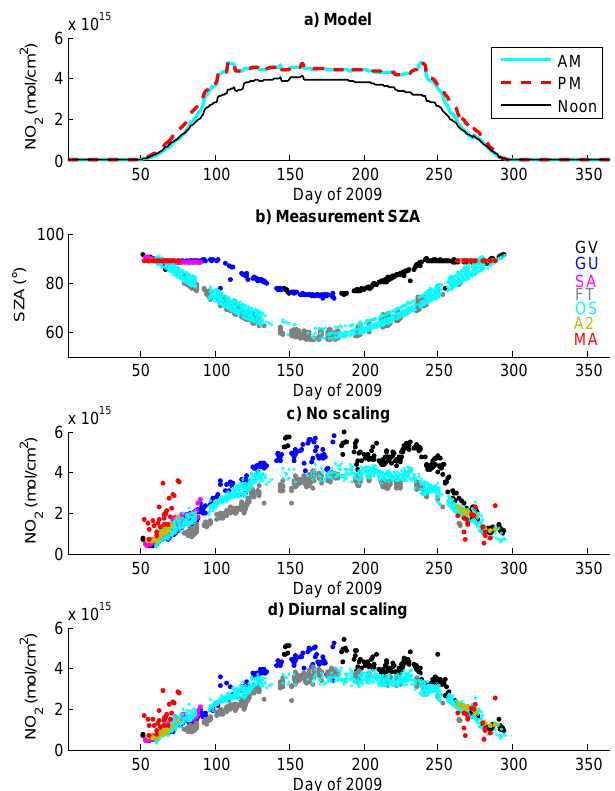
Fig. 3. Seasonal evolution of NO 2 in 2009. (a) 17–40km partial columns calculated by the photochemical model initialized with ozonesondes for morning twilight (thick cyan line), evening twi- light (red dashed line), and solar noon (thin black line). (b) Mea- surement SZAs. Note that ACE, the GBS, and SAOZ all measure at approximately the same SZA and, therefore, have overlapping data points. Similarly OSIRIS and the FTIR measure at approximately the same SZA. (c) NO 2 partial columns measured by ground-based and satellite instruments. (d) Same as (c) except all measurements scaled to solar noon using photochemical model. Instrument abbre- viations are given in Table